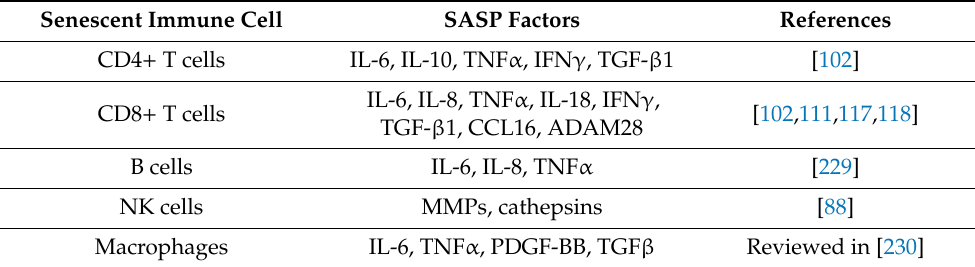
Table 1. SASP factors released by immune cells.